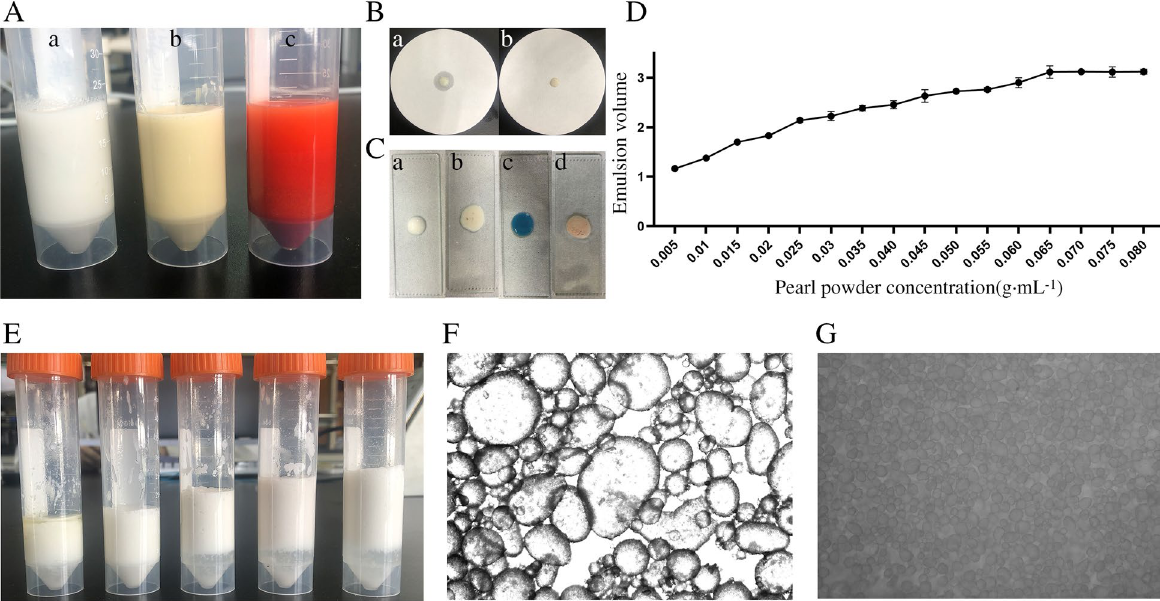
Fig. 1 Identification and preparation method of various medicinal materials into emulsion types. A State of forming emulsions ((a) pearl powder; (b) cinnabar; (c) amber). B Filter paper method to identify each herb into emulsion type ((a) pearl powder; (b) amber). C Staining method to identify the type of each herb into emulsion (before staining: (a) pearl powder, (b) amber; after staining: (c) pearl powder, (d) amber). D Emulsion volume of different pearl powder concentration. E Emulsion state of different oil‑water ratio. F Preparation by high‑speed dispersion method ( 100). × G Preparation by high‑pressure homogenization method ( ×